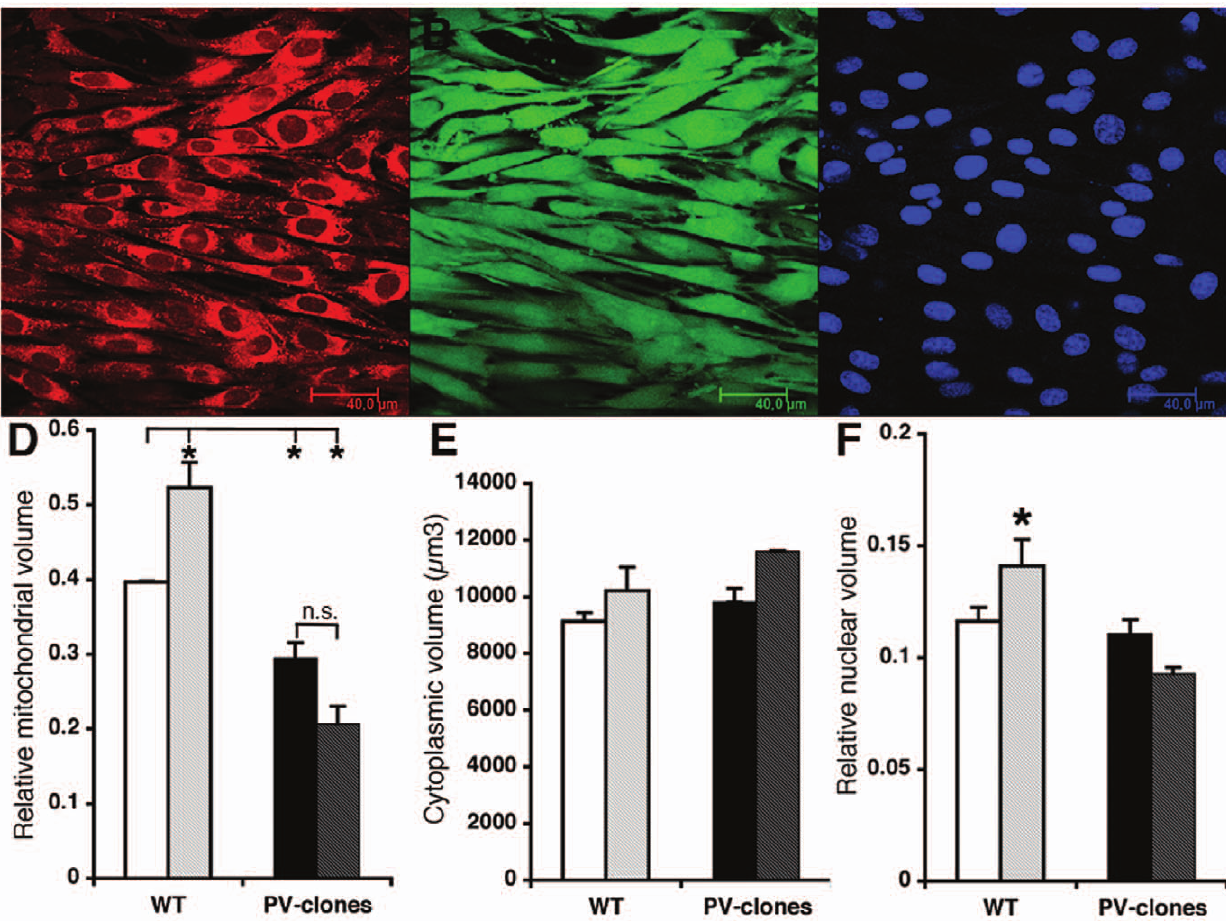
Figure 3. Volumetric analysis of mitochondrial content in WT and PV-transfected C2C12 cells. A–C: Confocal images of WT C2C12 cell loaded with Mito Tracker Red (A), Calcein-AM (B), DAPI (C): x–y image Z-stack projection (large image), x–z (bottom) and y-z (right) image. Scale bar is 40 m m. These images were transferred to Imaris 3D to calculate relative mitochondrial volume. D–F: Bar histographs of relative mitochondrial volume (D), cytoplasmic volume (E) and relative nuclear volume (F) in C2C12 WT (light bars) and PV-clones (dark bars) either in control medium (left bars) or incubated for 48 h with Br-A23187 (1 m M; right bars). D) The relative mitochondrial volume was increased in WT C2C12 after ionophore treatment (*; p , 0.05). The mitochondrial volume in PV-clones, both in control medium or after 48 h ionophore treatment was lower than in untreated WT C2C12 cells; * p , 0.05 vs. WT; n . 30 cells). The decrease in mitochondrial volume in PV-clones after ionophore treatment was not significant (n.s.) E) No differences in cytoplasmic volumes were detected. F) The nuclear volume in ionophore-treated WT C2C12 was slightly larger than in untreated WT cells (*; p , 0.05).